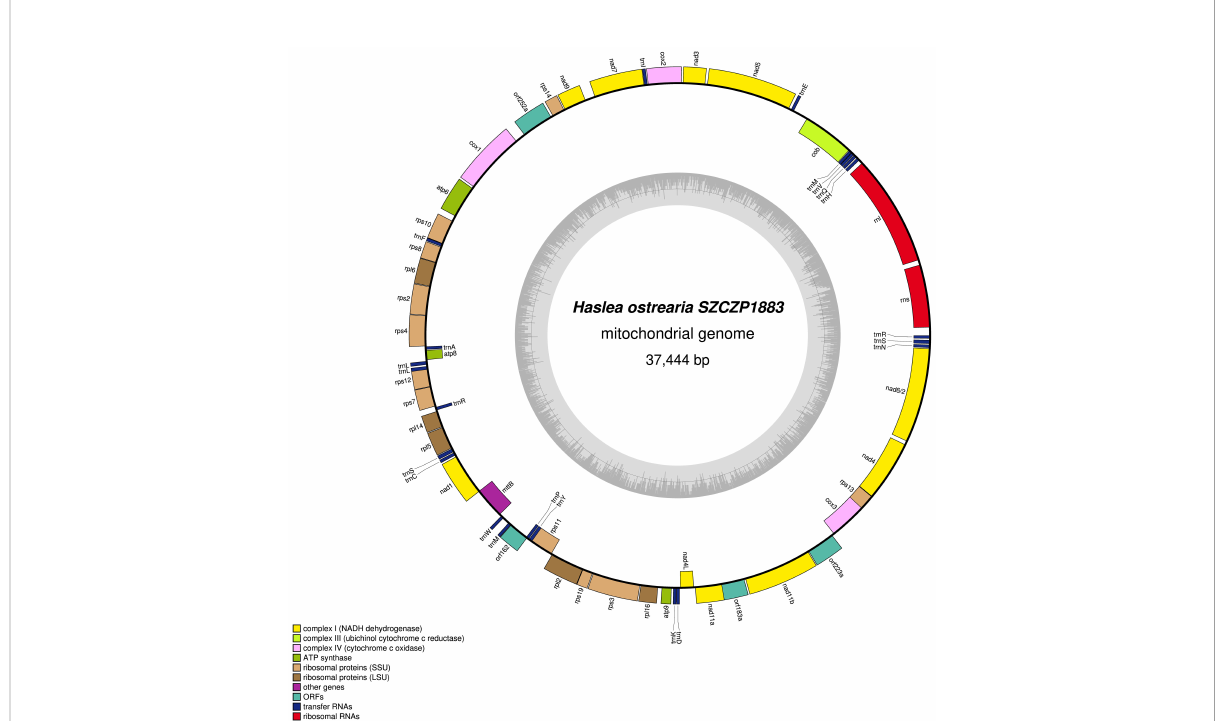
FIGURE 3 Map of the mitochondrial genome of Haslea ostrearia SZCZP1883. The legend in the lower left part of the graph indicates the type of genes and features represented. Genes displayed on the outside were found on the positive strand, genes displayed on the inside were found on the negative strand. The grey graph indicates the GC